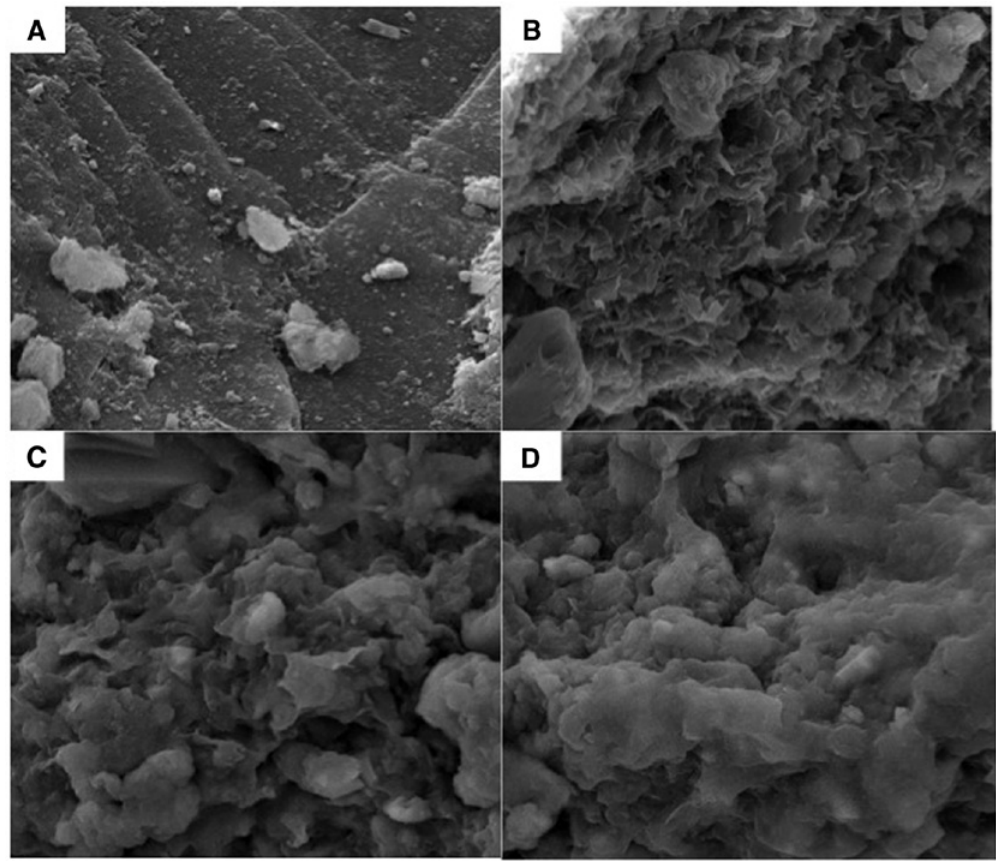
Figure 4 Surface morphology of (A) MMT, (B) OMMT (STAB), (C) OMMT (DOAB), and (D) OMMT